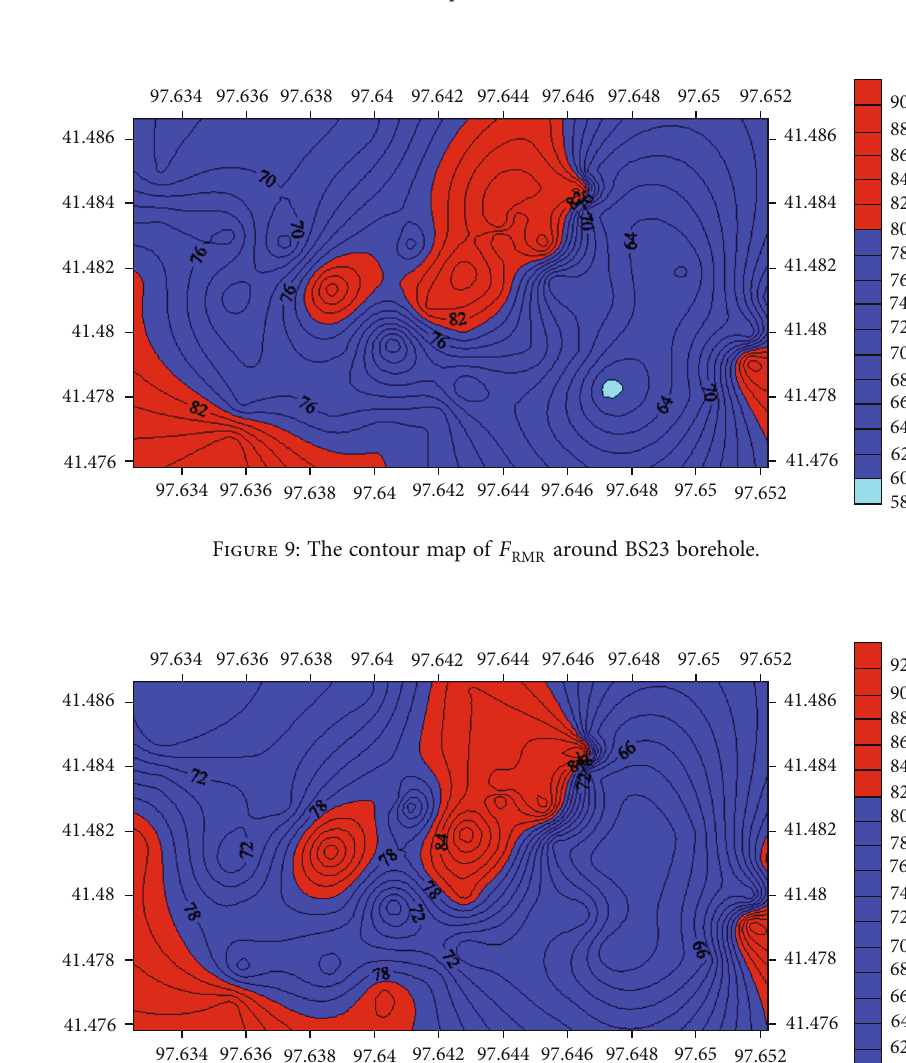
RMR around BS23